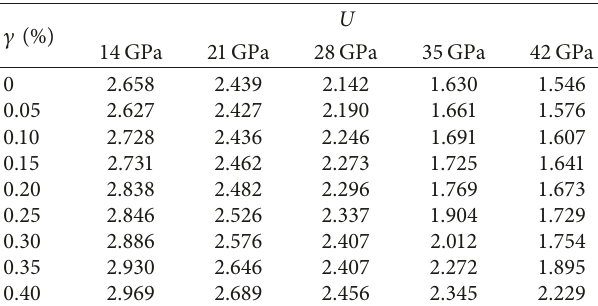
Table 3: Energy consumption density for mechanical damage calculation (unit: J · cm − 3